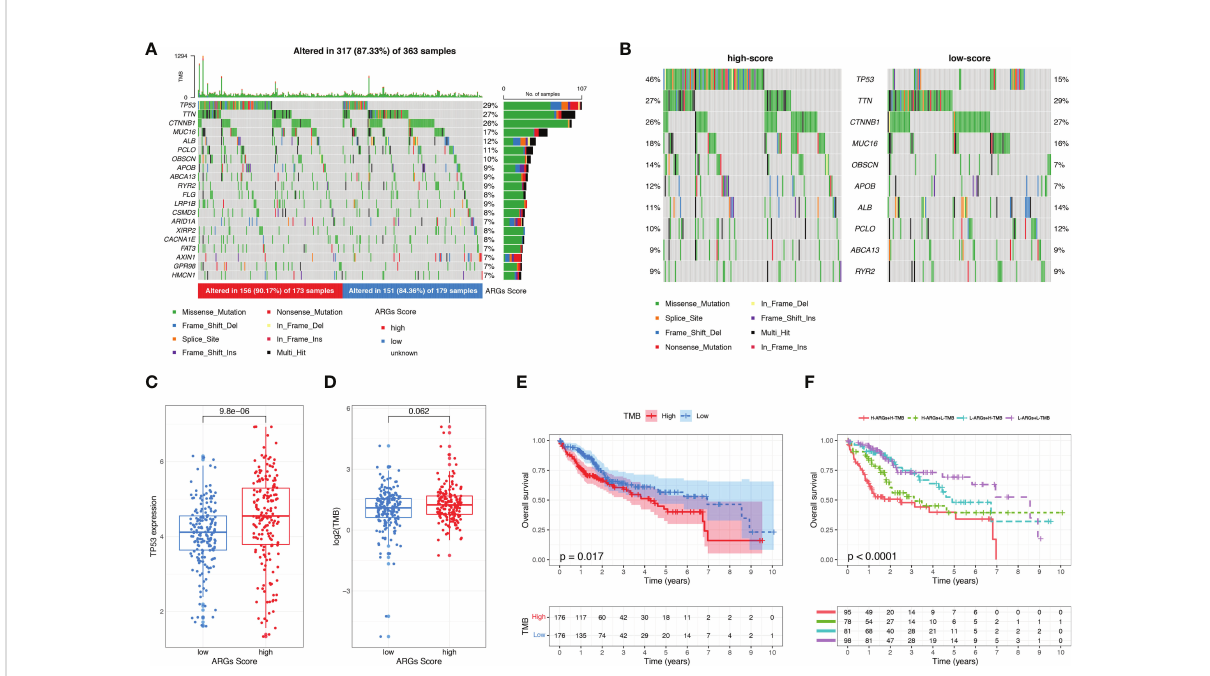
FIGURE 8 The mutation landscape and tumor mutation burden analysis. (A) Waterfall plots about the mutation distribution of the top 20 most frequently mutated genes in HCC patients from the TCGA dataset. (B) Comparison of the top 10 mutation genes between low-score and high-score groups. (C) The expression of TP53 between low-score and high-score groups. (D) TMB between low-score and high-score groups. (E) KM analysis of HCC patients strati fi ed by TMB. (F) The survival analysis of HCC patients based on the combination of ARGs Score and TMB.